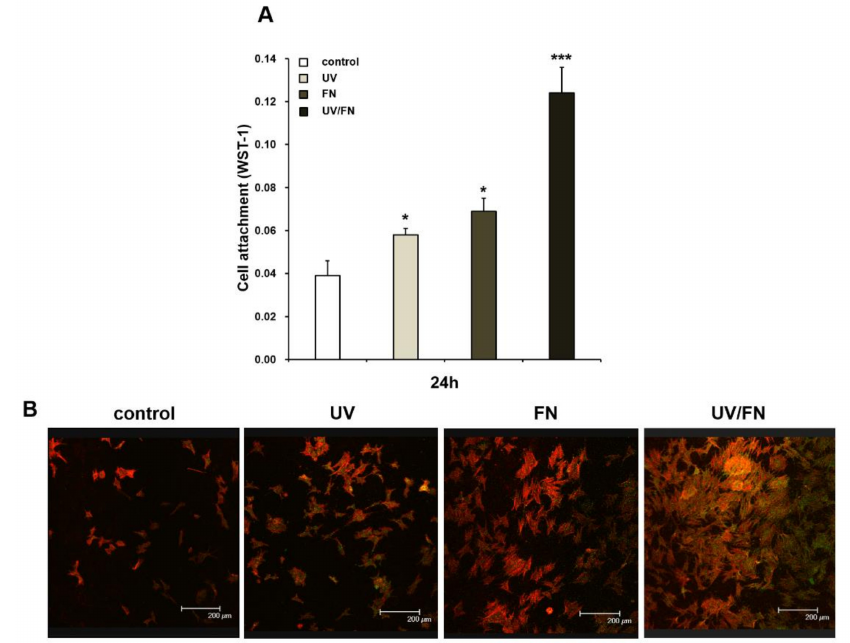
Figure 3. Attachment of rat bone marrow-derived osteoblasts on control, UV-treated (UV), fibronectin-adsorbed (FN), and UV-treated and fibronectin-adsorbed (UV / FN) titanium surfaces. A 1-h adsorption protocol was used in this experiment. ( A ) The number of attached cells after 24-h incubation was evaluated by water soluble tetrazolium salts-1 (WST-1) assay. ( B ) Microscopic appearance. Theinitialspreadofosteoblastsat24hafterseedingoncontrol, UV,FN,andUV / FNtitanium surfaces. Representative confocal microscopy images of cells stained with rhodamine-phalloidin, for actin filaments (red), and anti-vinculin, for vinculin (green). Each value represents the mean ± standard deviation from triplicate experiments ( n = 3). * p < 0.05 and *** p < 0.001 represent significant di ff erences relative to the control surface. Scale bar = 200 µ